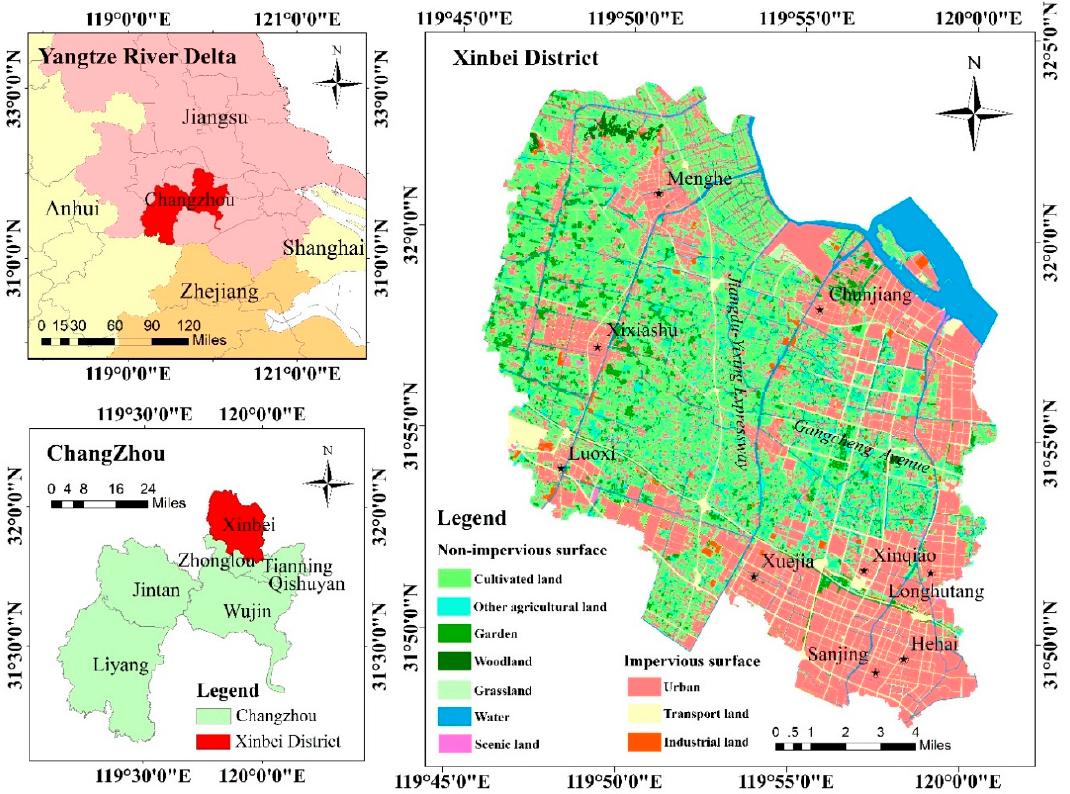
Figure 1. The location of Xinbei District.